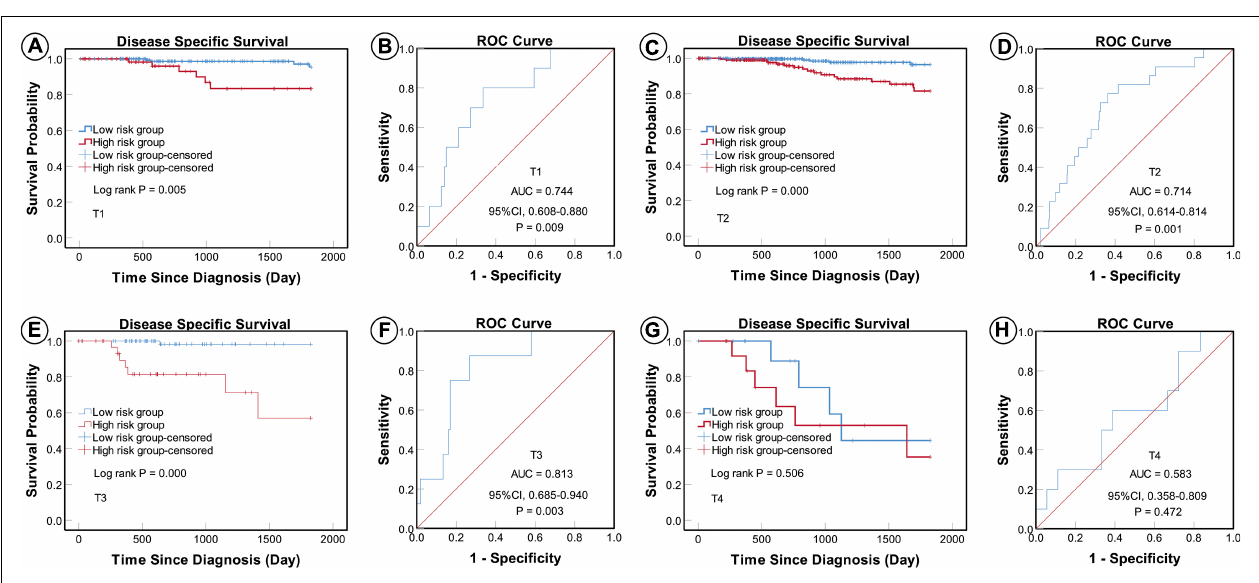
FIGURE 6 | KM and ROC curves for patients stratified by tumor size. KM analysis showed that the patients in the low-risk group had significantly better DSS in the T1 (A) , T2 (C) , and T3 (E) subgroups, but not in the T4 (G) subgroup. ROC analysis showed that the five-miRNA signature exhibited high sensitivity and specificity in predicting the prognosis of patients with BC in the T1 (B) , T2 (D) , and T3 (F) subgroups, but not in the T4 (H)